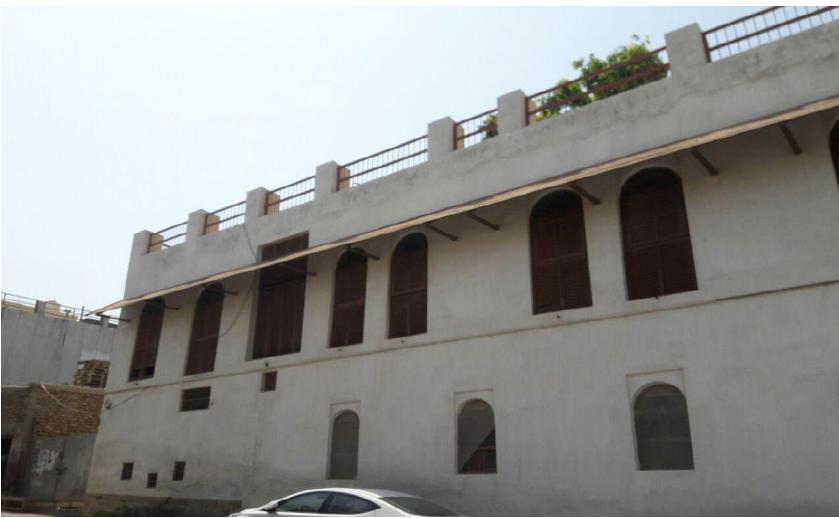
Figure 6. Using light color and outer openings.